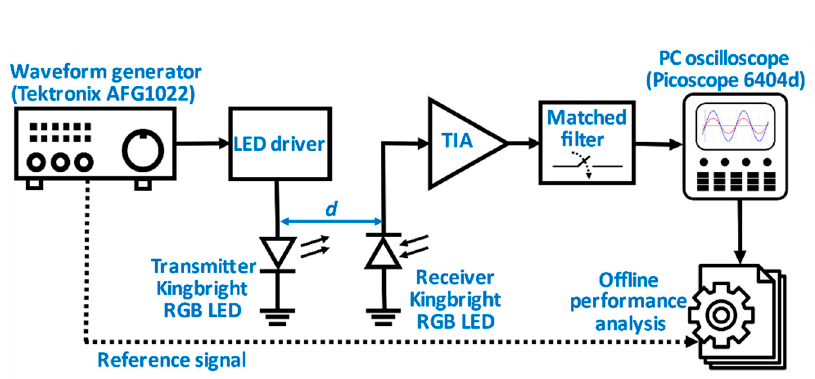
Figure 1. Block diagram of the proposed experimental setup.